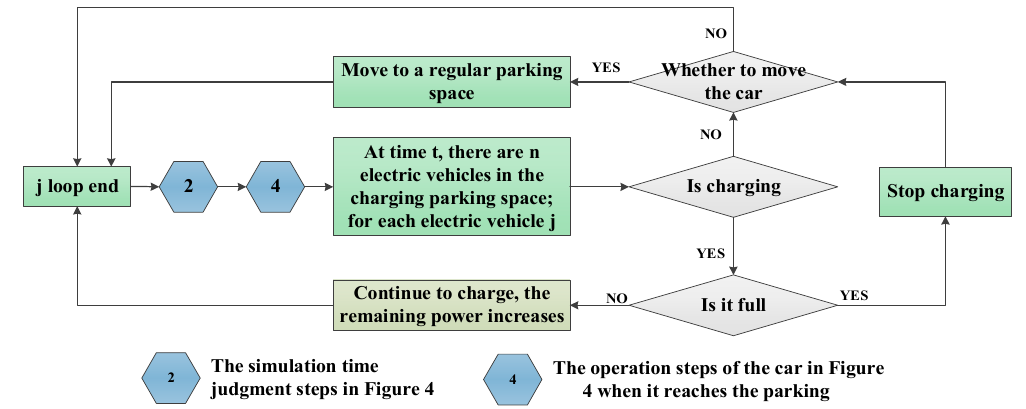
Figure 6. Flowchart of charging operation in penalty model.